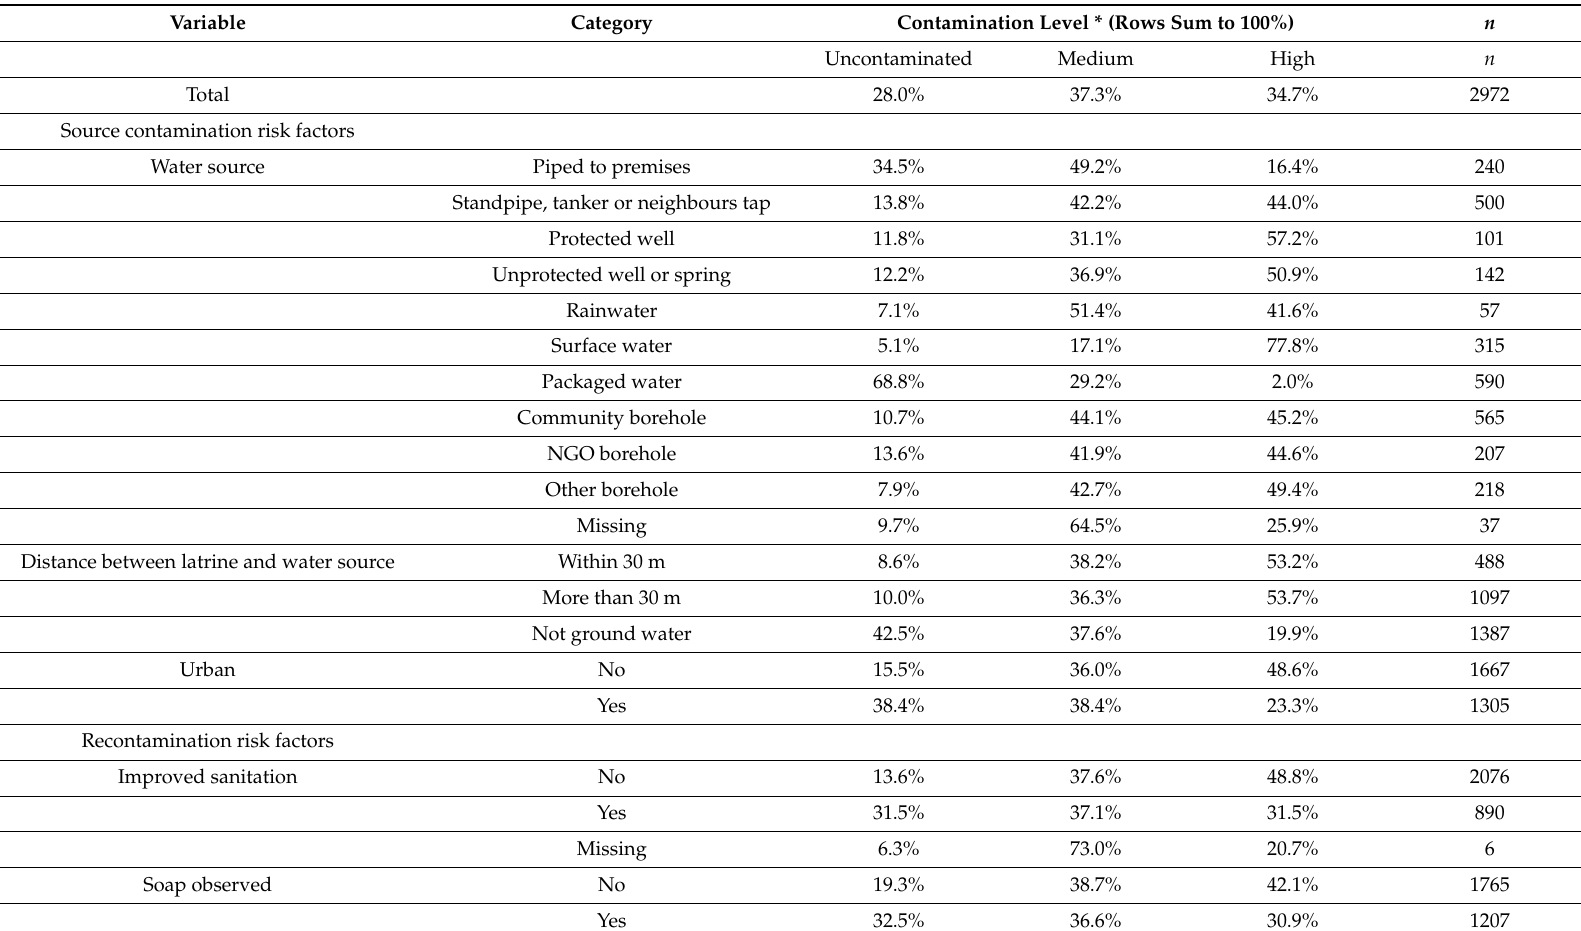
Table 1. Descriptive statistics for E. coli contamination of water at the point of consumption, n =